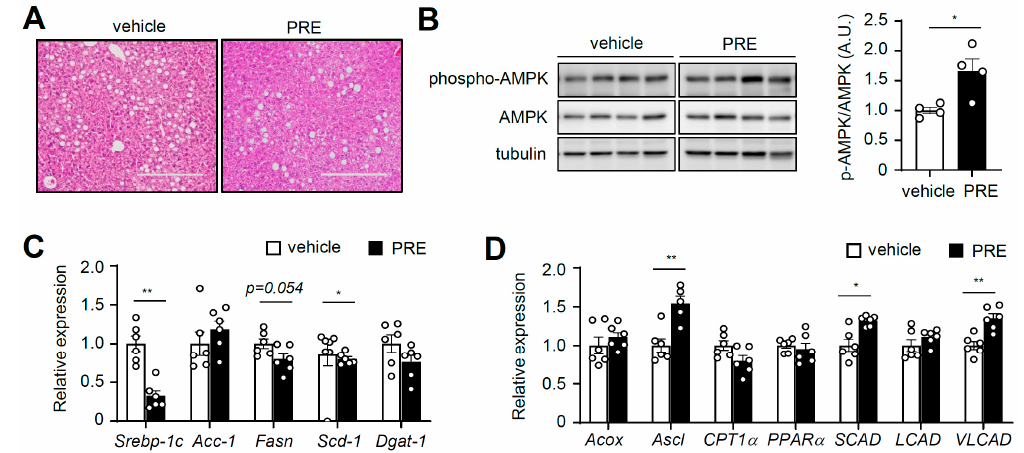
Figure 5. PRE ameliorated hepatic steatosis. Liver was isolated from vehicle- or PRE-treated DIO mice in the non-fasted state. ( A ) Liver sections for H&E staining (the scale bar is 125 µ m). ( B ) The extracts were analyzed with phospho-AMPK, AMPK, and tubulin by Western blot. Data are shown as the mean ± S.E.M. ( n = 4) * p < 0.05; ** p < 0.001; *** p < 0.0001 vs. HFD-fed vehicle group. The mRNA levels of lipogenic genes ( C ) and fatty acid oxidation related genes ( D ) were analyzed by quantitative real-time PCR. Data are shown as the mean ± S.E.M. ( n = 6) * p < 0.05; ** p < 0.001; *** p < 0.0001 vs. HFD-fed vehicle group.